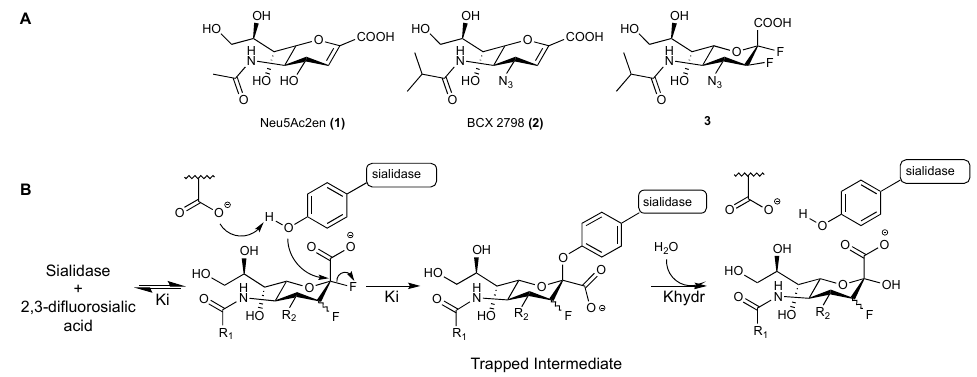
Figure 1. ( A ). Structures of Neu5Ac2en ( 1 ), BCX 2798 ( 2 ), and the difluoro analogue of BCX 2798 ( 3 ); ( B ). Proposed catalytic mechanism for all of the studied sialidases confirmed by the X-ray crystal structures of the trapped neuraminosyl–enzyme intermediate.